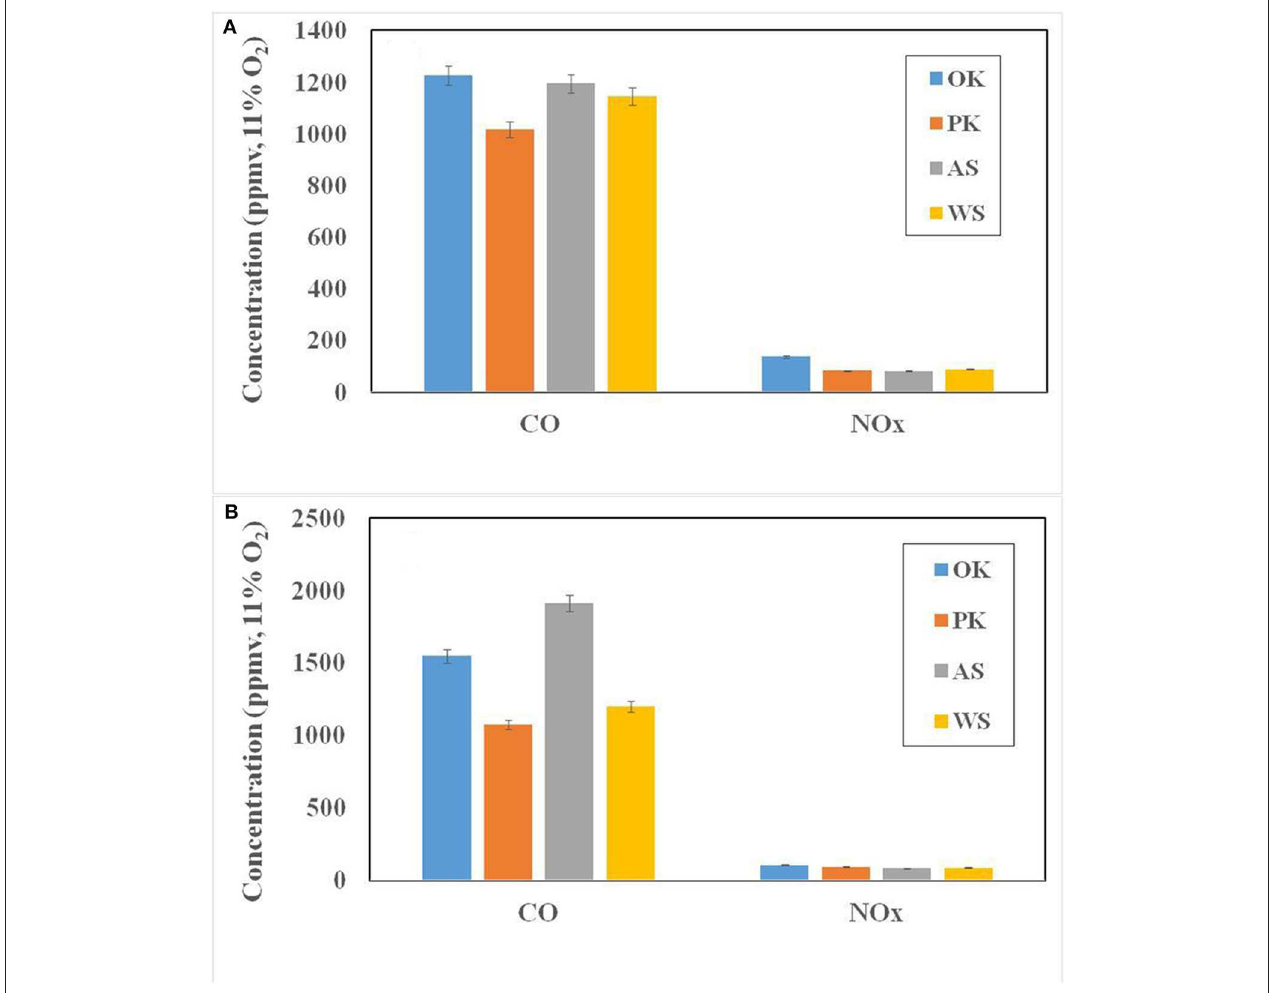
FIGURE 4 | Average pollutant concentrations of gases from raw fuels (A) at steady state and (B) during whole operation of